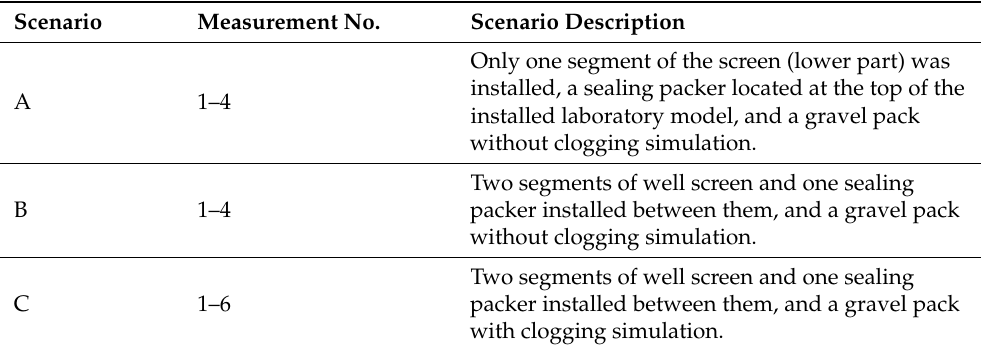
Table 1. Scenarios measured in laboratory tests on a model of an extraction well. Scenario Measurement No. Scenario